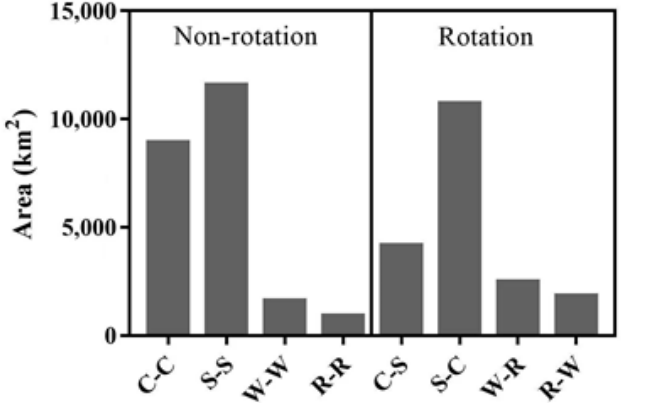
Figure 11. Rotation and non-rotation areas of different crop types from 2017 to 2018. (Note: W: Wheat, R: Rapeseed, S: Soybean, C: Corn).